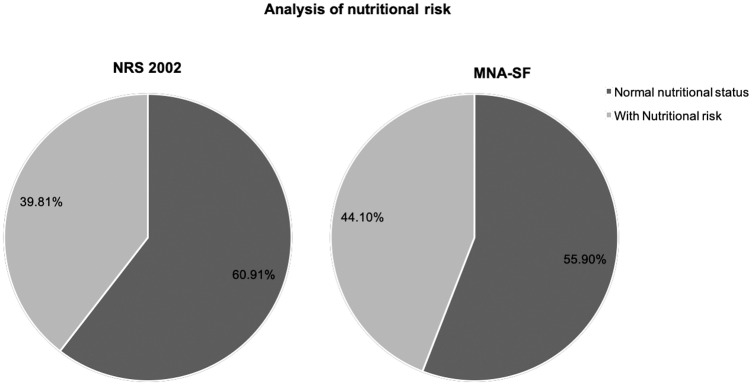
Analysis of nutritional risk using NRS 2002 and MNA-SF.